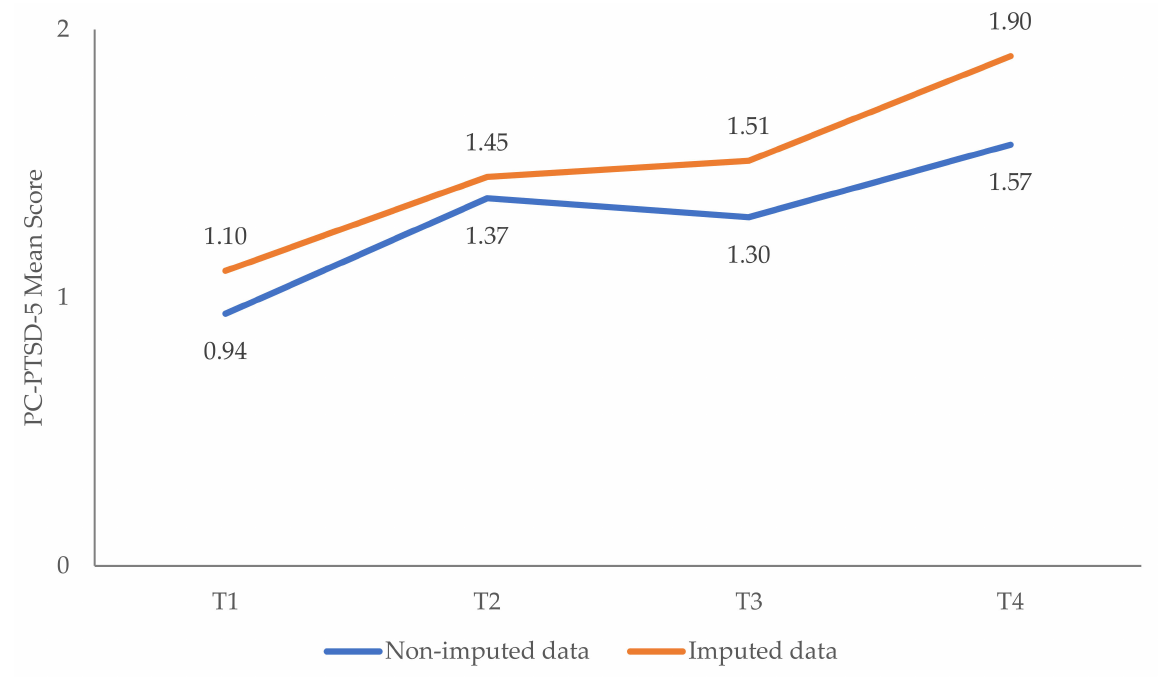
Figure A4. Changes in symptoms of PTSD (PC-PTSD-5) over time: imputed vs. non-imputed results. Note: Imputed dataset: n = 1001. Non-imputed dataset: n t1 = 221. n t2,3 = 35. n t4 = 46.